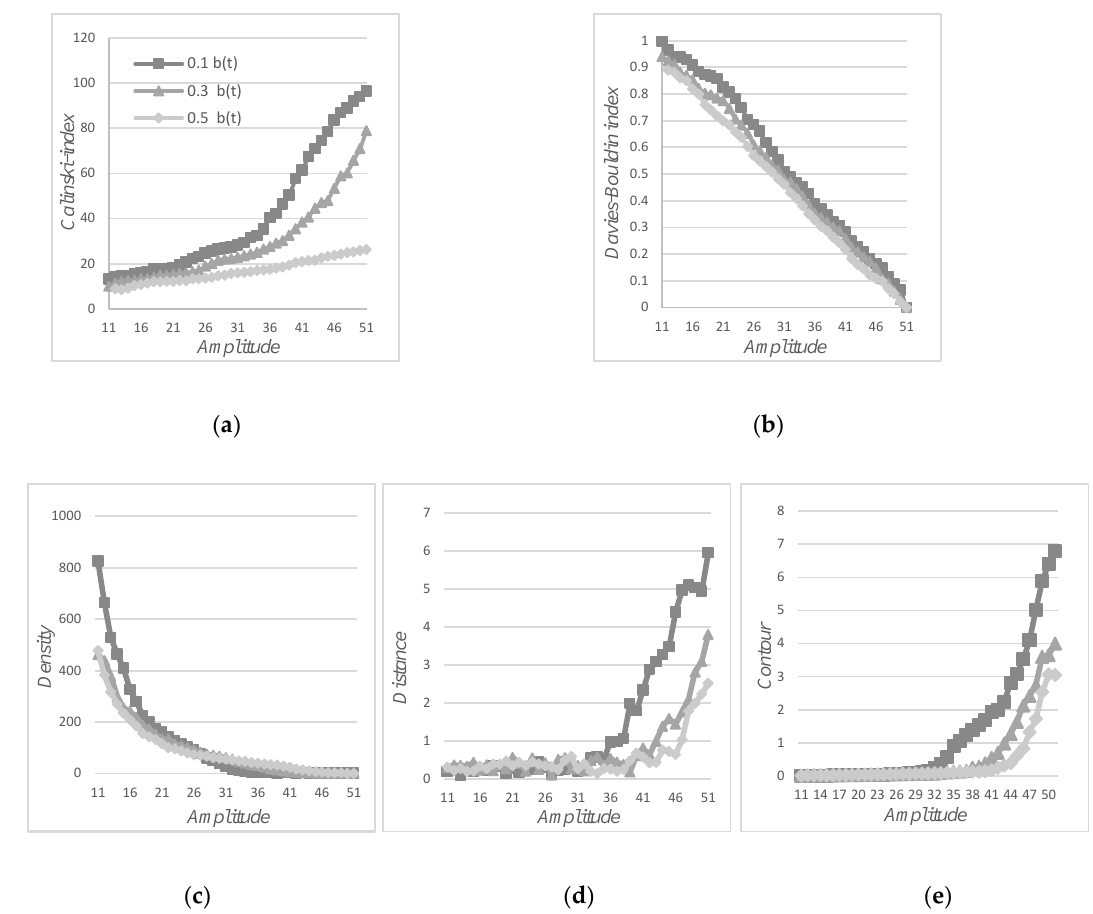
Figure 7. ( a ) Calinski index, ( b ) Davies–Bouldin index, ( c ) density, ( d ) distance and ( e ) contour.